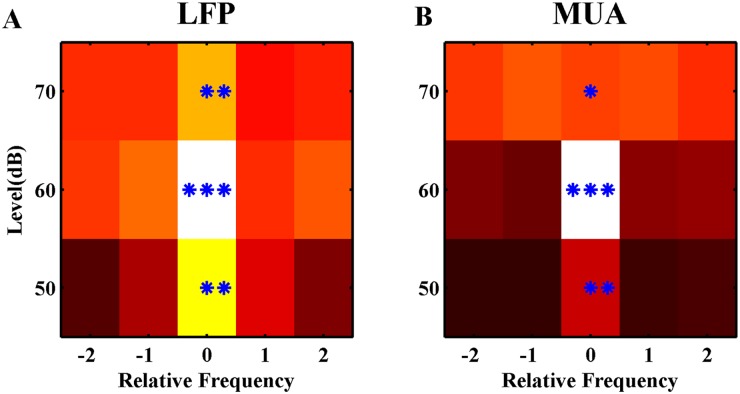
The difference between neural responses of adapted and control sequences.A. The distance btween control and adapted sequences responses in different combinations. The colors shows this distance from dark to white. Adapter response (stimulus with relative frequency ‘0’ and at the level of 60 dB) shows the largest decrease. Whatever, by distancing from adapter, this decreasing effect becomes lower. The adaptation effect is significant in the adapter and the combinations with the same frequency and different levels. (t-test; P<0.001_***, p<0.01_**, p<0.05_*).